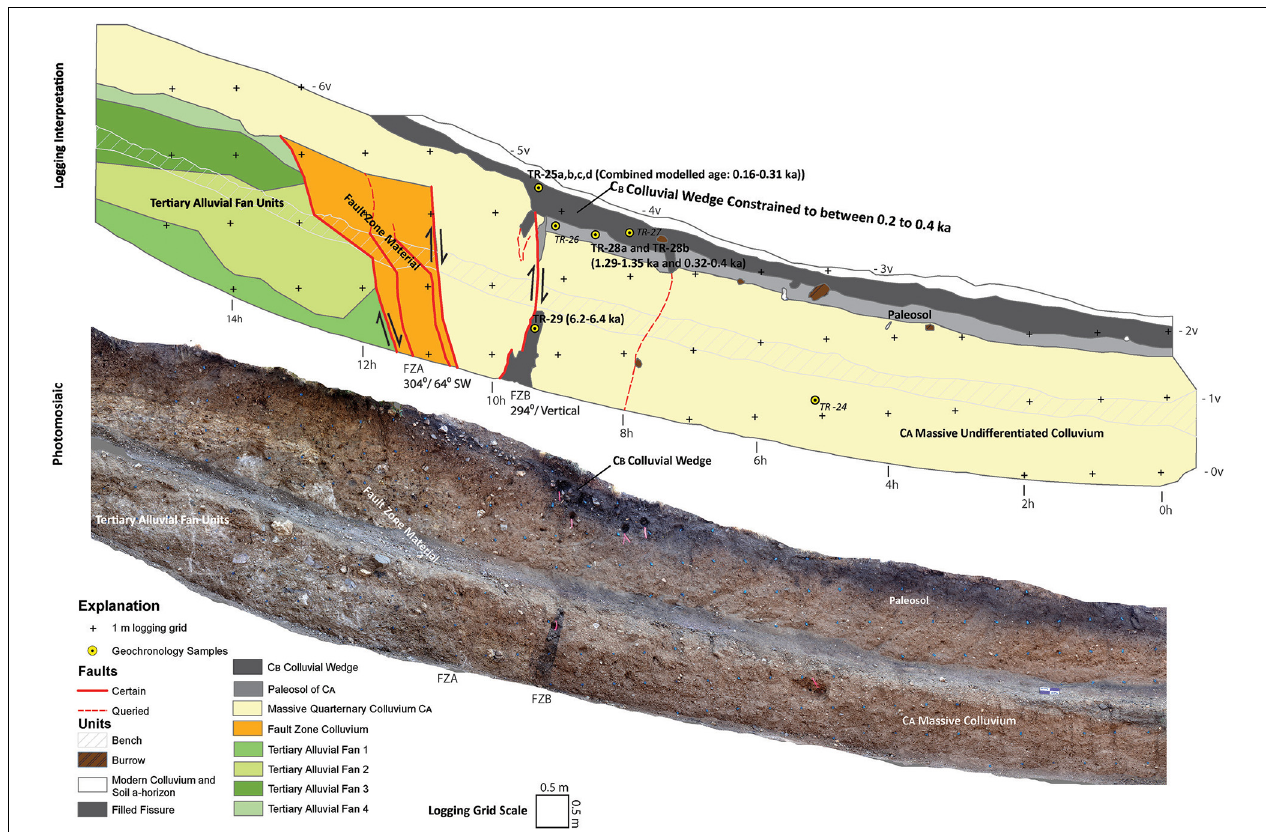
FIGURE 5 | Trench One South (T1S), east wall. Paleoseismic logging interpretation and photomosaic. The most recent event at TR site occurred along fault zone B, forming the C B colluvial wedge. This event is constrained to between 0.2 and 0.4 ka by samples TR25a – d and TR28a – b ( Figures 7 , 8 and Table 2 ). The C B colluvial wedge has been significantly modified by erosion on the west wall ( Figure 6 ). Based upon the presence of older soil A-horizon material within the fault zone B (FZB) fissure (TR29), we infer that an older Holocene event occurred along this fault between 1.3 and 6.2 ka. However, the primary evidence for this event has been removed due to erosion. The older C A colluvium is massive and was undifferentiable. We expect it is colluvium derived from recurrent motion along FZA, but we did not document any evidence to constrain events along this fault zone. Undated samples are shown in italics and smaller